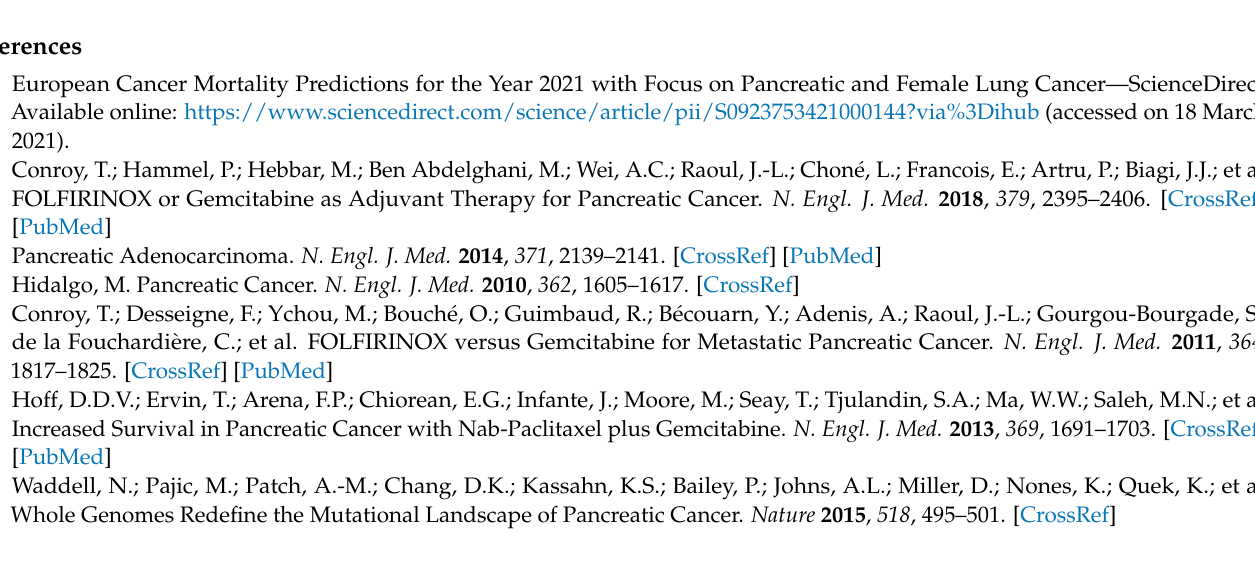
Figure S2: Mutational signature analysis of whole exome sequencing data from the whole population of pancreatic tumors; Figure S3: Analysis of homologous repair aberrations, SNV or CNV signatures 3 and HRD score; Figure S4: Validation of the overall survival models in the gemcitabine group; Table S1: Description of treatment based on molecular tumor board recommendation; Table S2: Hazard ratio with 95% confidence intervals for variables selected through bootstrap strategy for each of the models, estimated using multivariate Cox models with lasso penalty; Table S3: Description of genes involved in signaling pathways of